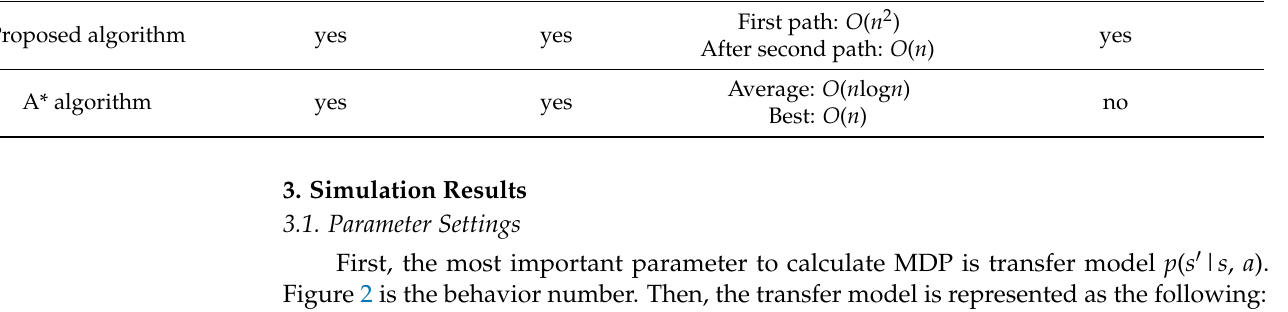
Table 1. Algorithm analysis between the proposed and A* algorithm. Completeness